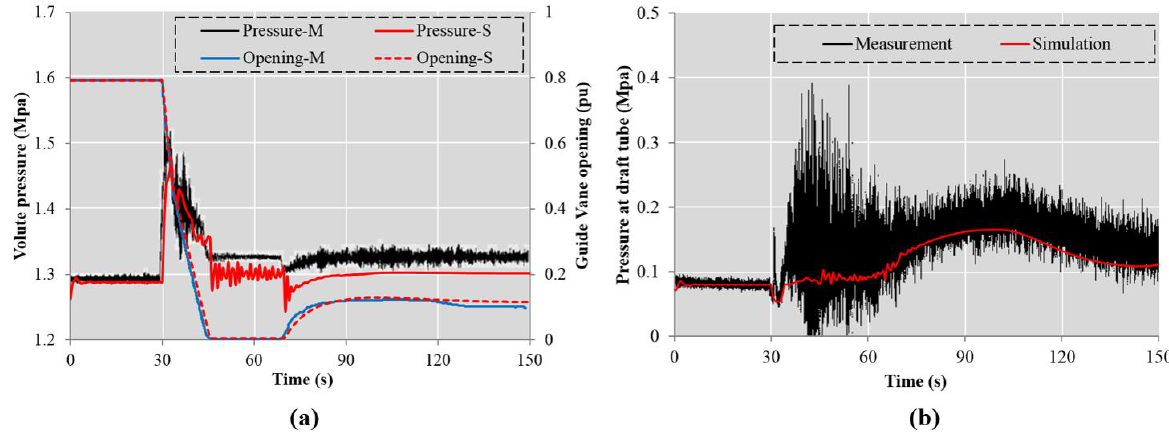
Figure 10. Simulation and measurement of the ( a ) guide vane opening and pressure at volute; and ( b ) pressure at draft tube, during a load rejection process (Case